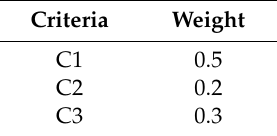
Table 12. Weight Table 12. Weight matrix.